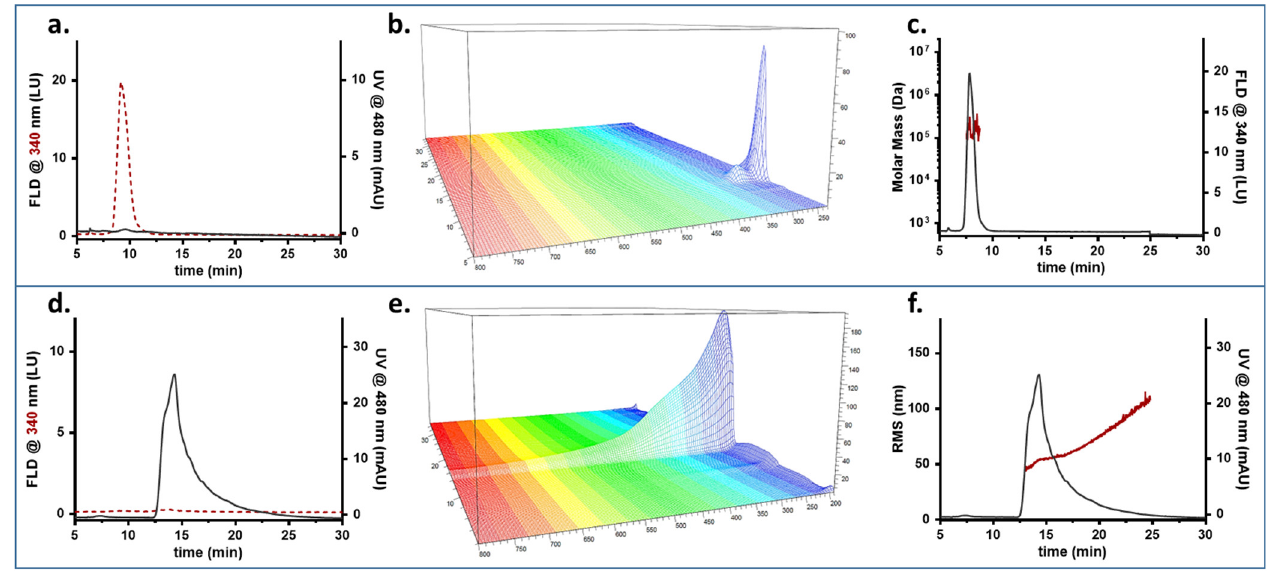
Figure 4. FFF fractogram (red dashed line: fluorescence signal; grey line: absorption signal), UV-Vis absorption spectrum, and Molar Mass/RMS radius (red) and fluorescence/UV profile (grey) obtained for HSA ( a – c ) and MNPs ( d – f ).